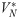
Timely assessment of conformity to Benford’s law – statistics on compliance and efficiency in combatting money laundering.While in accordance with Table 3, for visual purposes the measures VN* has been divided by a factor 10.